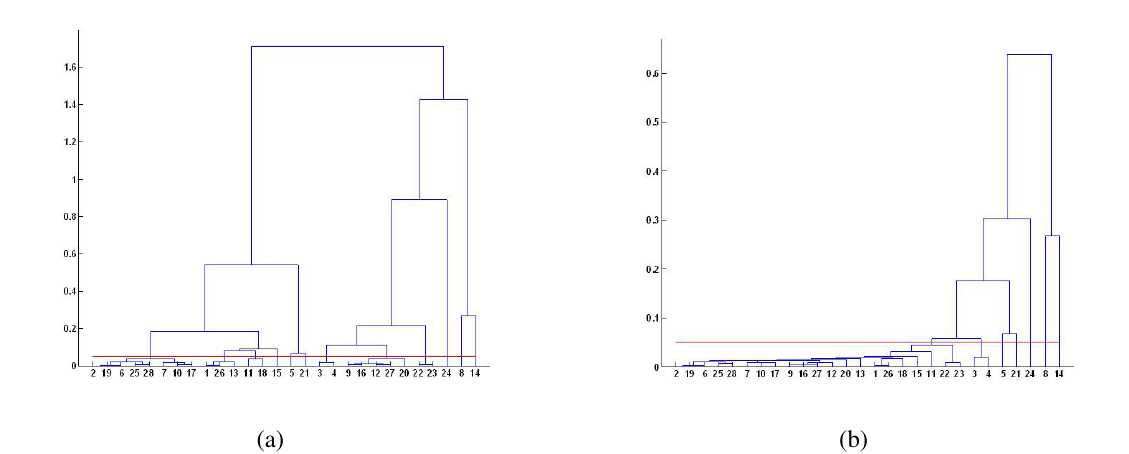
Figure 5: Result of hierarchical clustering on 28 genes of rat data. (a) with complete linkage, (b) with single linkage. The red line cut the tree at 0.05 and partition the gene into several clusters.